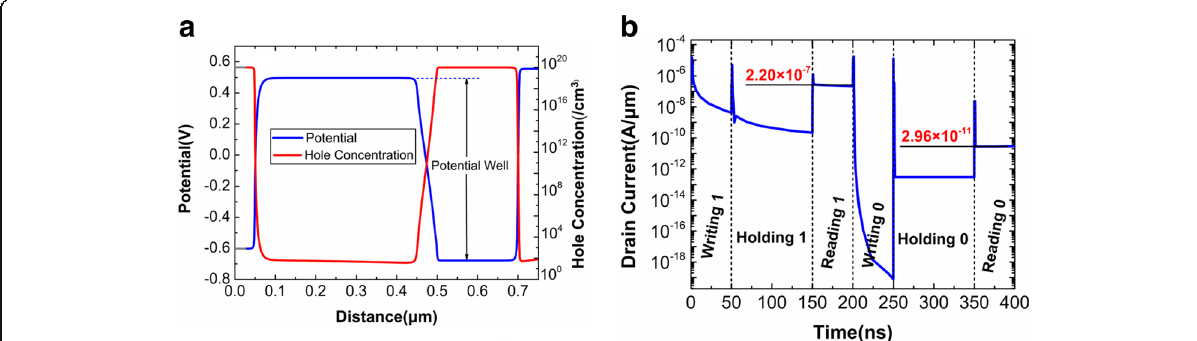
Fig. 3 a Potential and hole concentration on the surface of channel after writing “ 1 ” . b Transient response of drain current for DGTFET DRAM operated in Table 1